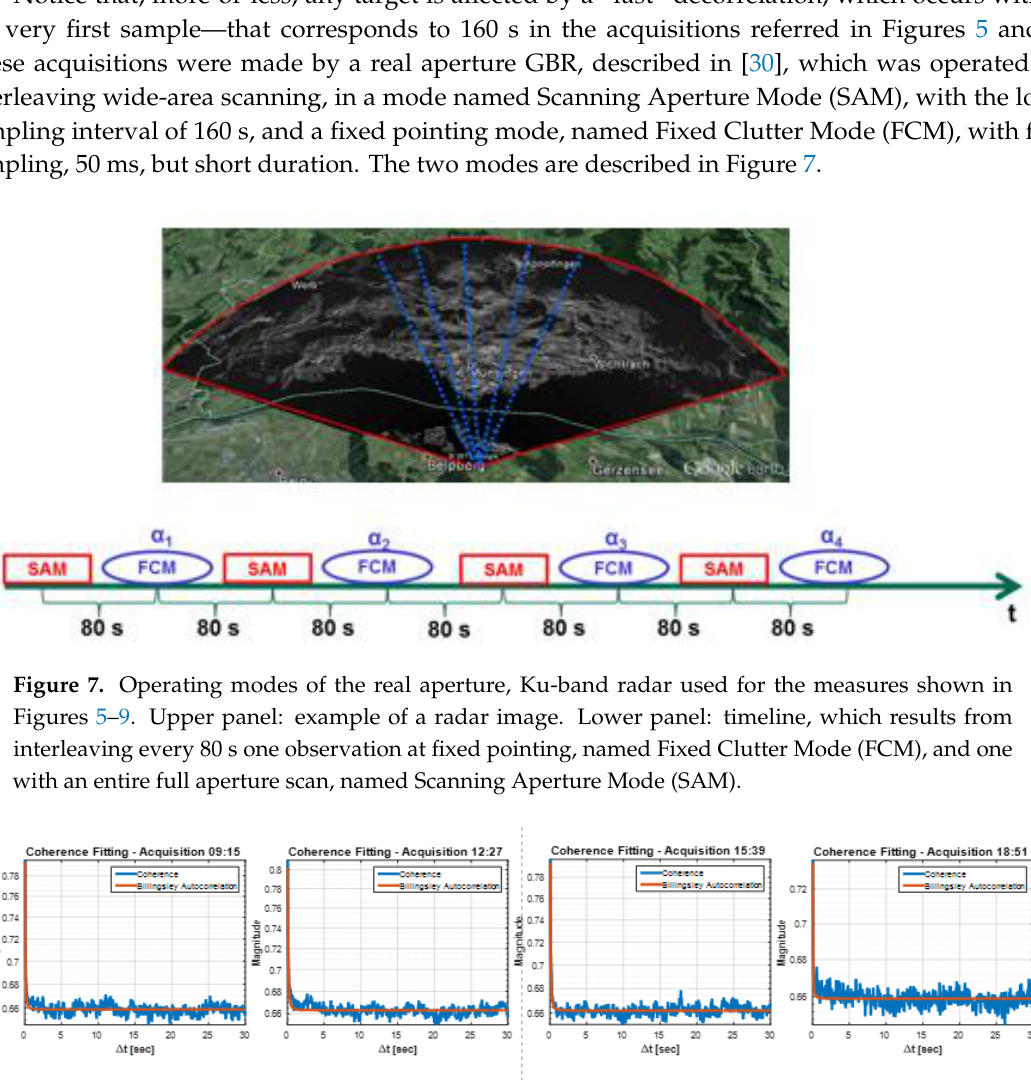
Figure 8. Coherence time series of a target over the forest, measured on 2 September, 2014, location Mount Bre (Lugano, CH), on the same target, in the short interval at different times of the day, superposed with the fitting ICM model.